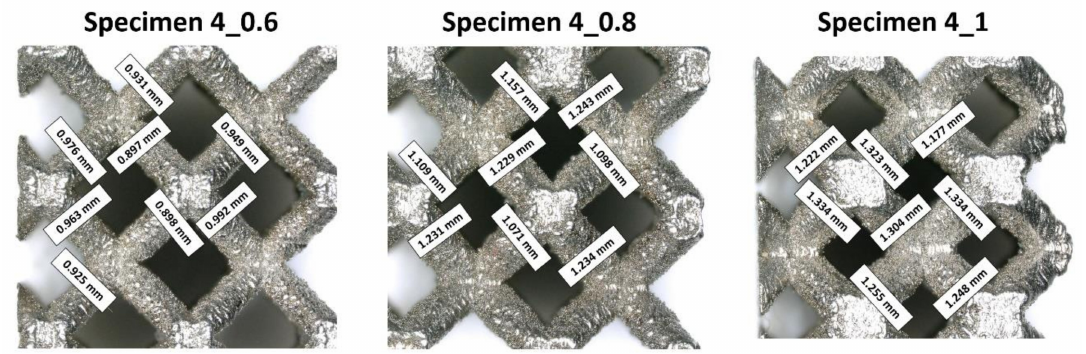
Figure 8. The dimensional deflections of the lattice structure struts measured from the side view (perpendicular to the building